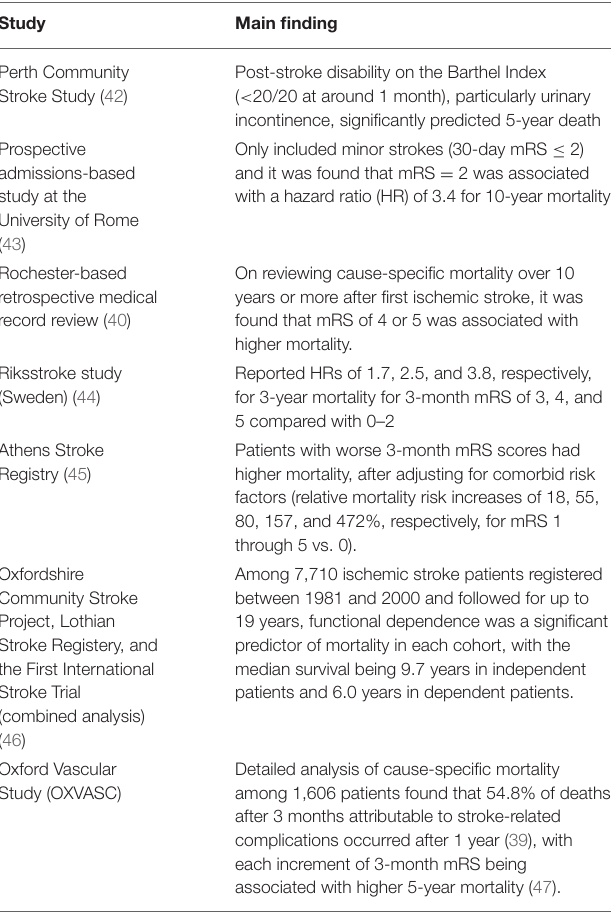
TABLE 1 | Key observational studies examining the relationship of short-term post-stroke disability or functional outcome to 5-year (or longer-term) mortality.